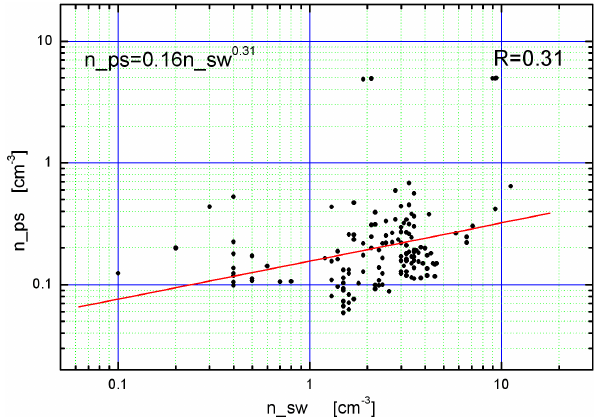
Fig. 4. The relationship between the dynamic pressure of the solar wind and density in the plasma sheet.